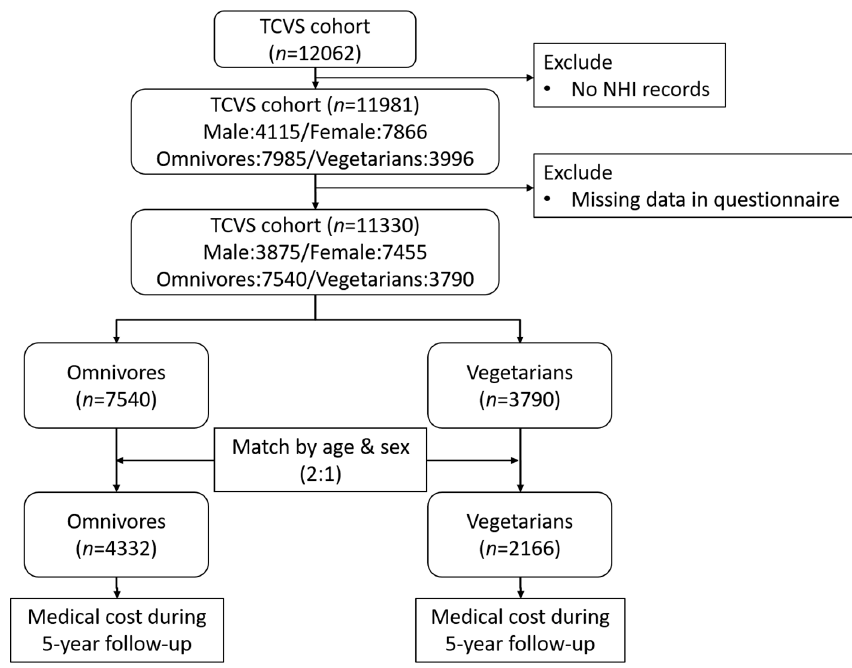
Figure 1. The study protocol.